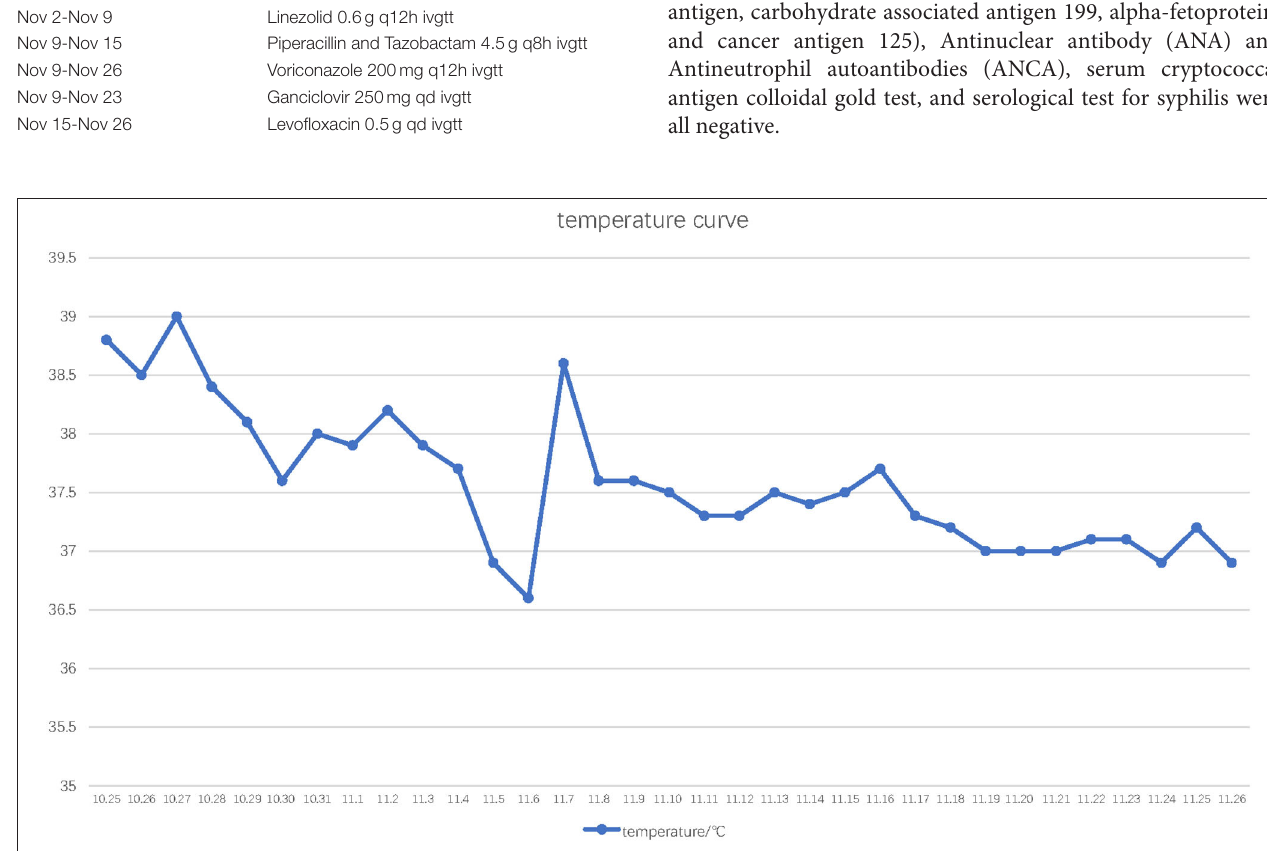
Frontiers in Medicine |